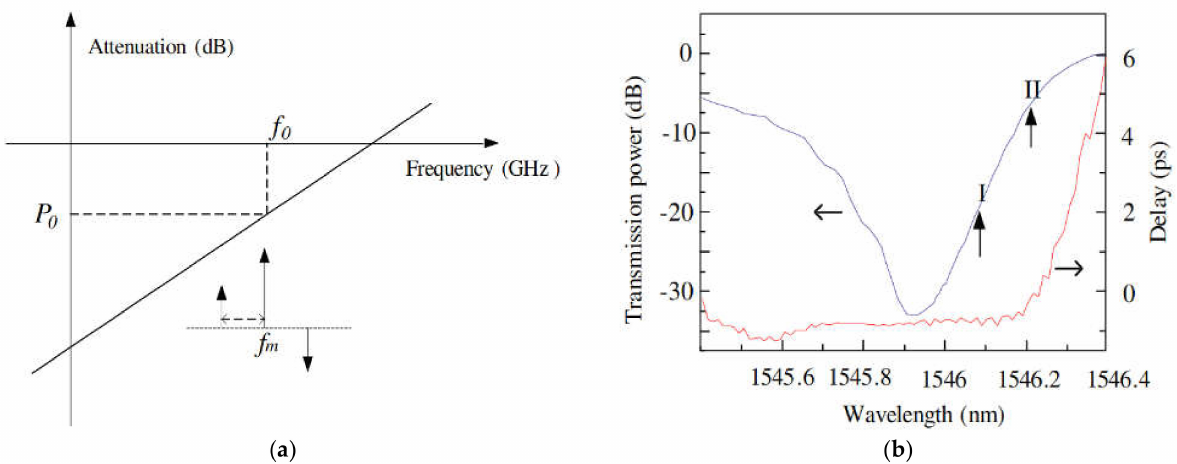
Figure 10. IFM method using an FBG as a tilt filter: ( a ) Block diagram of the characteristics of an external tilt filter; ( b ) transmission spectrum and dispersion characteristics of the chosen fiber Bragg grating (Reprinted with permission from Ref [27]. Copyright 2011, Taylor & Francis).